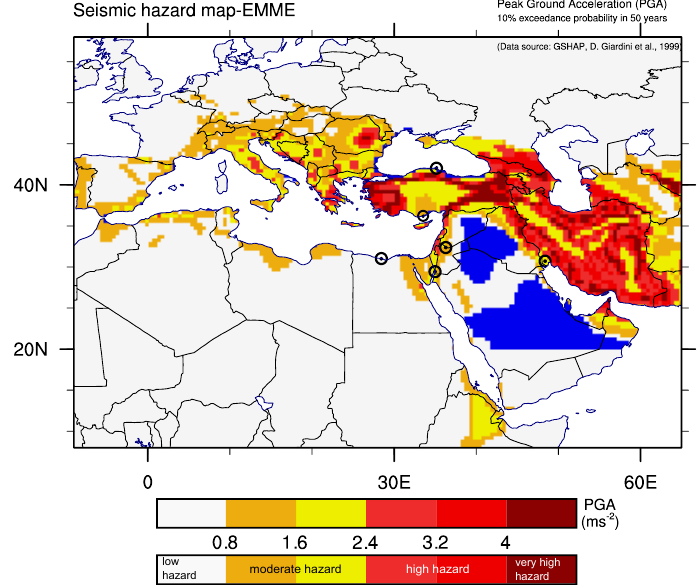
Figure 2. Geographical distribution of emission sites corresponding to nuclear power plants that are under construction or planned in the EMME region (black circles, source: WNA Reactor Database), superposed on a map of the regional seismic hazard to peak ground acceleration (50-year 10% exceedance probability), adapted from the Global Seismic Hazard Assessment Program (GSHAP) [17,18]. Blue regions indicate no data